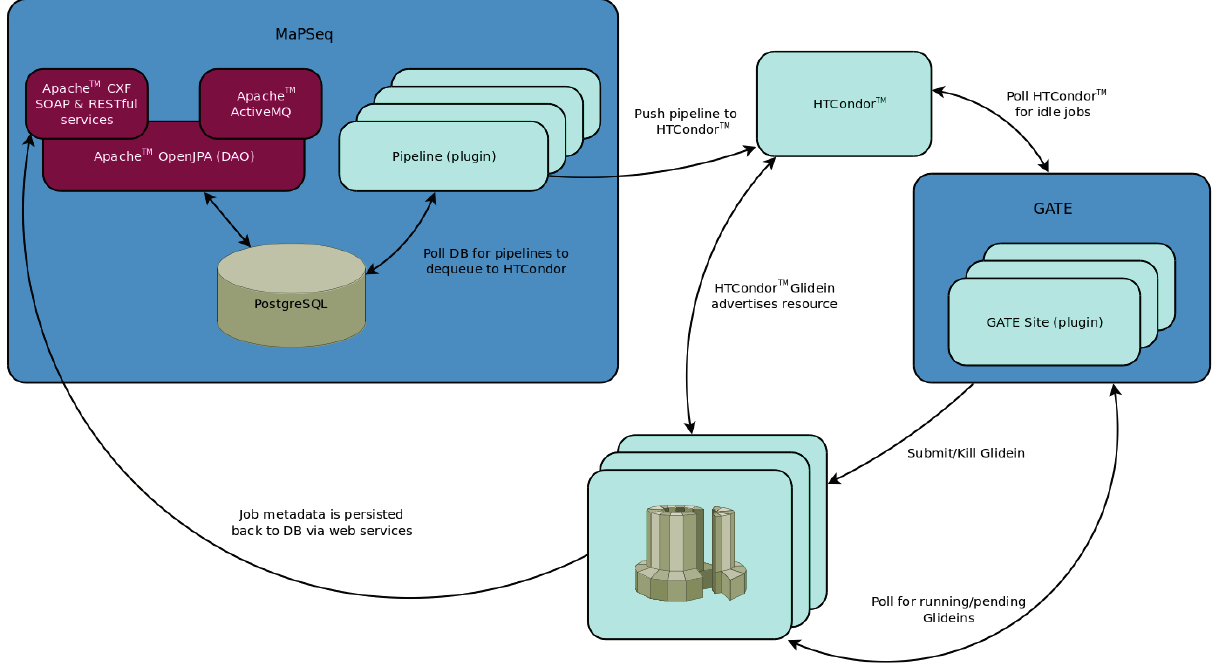
Figure 1. An overview of the MaPSeq